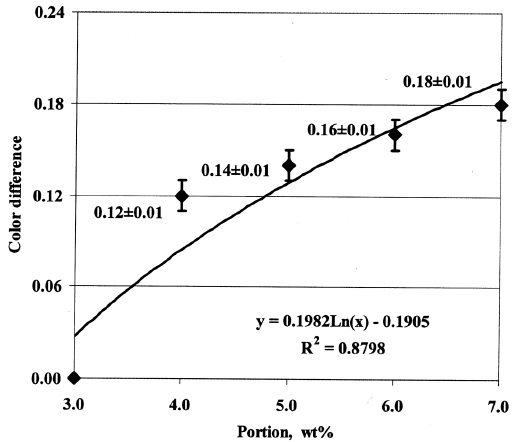
Figure 4: Effect of portion of additive Granic 422 on color difference of tapes.